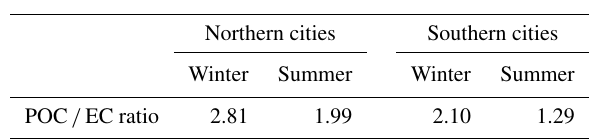
Table 3. The primary OC / EC ratios over China in 2003 proposed by Cao et al.